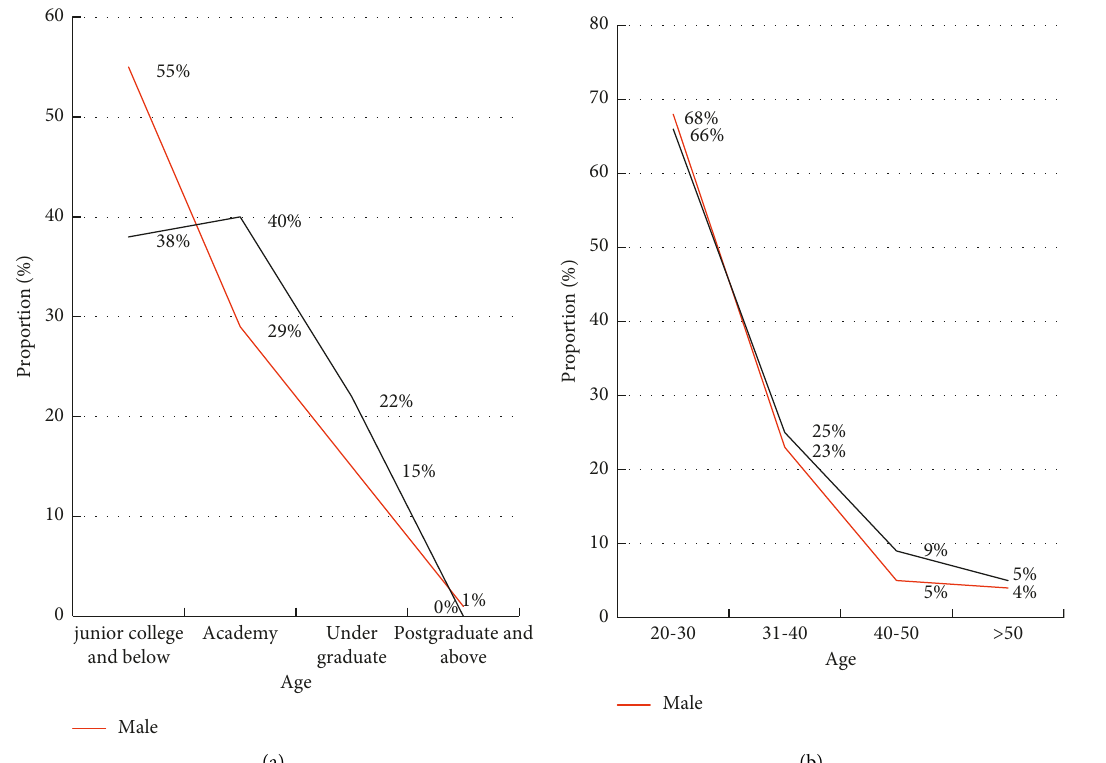
Figure 8: Schematic diagram of educational level and age distribution of swimming social sports instructors.